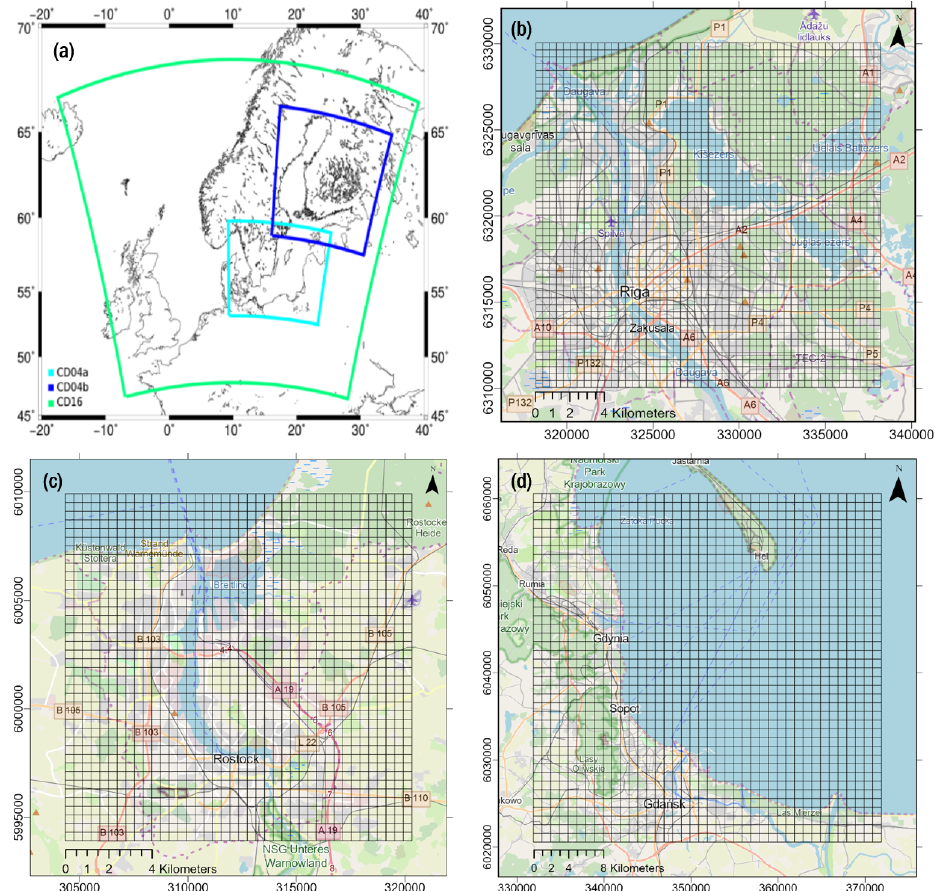
Figure 2. (a) Regional CTM simulation domains, which have been used to drive the local-scale EPISODE-CityChem simulation for the urban domains in (b) Riga and (c) Rostock, with 400m resolution for 20km × 20km and 16km × 16km extent, and (d) Gda´nsk–Gdynia, with 1000m resolution and 40km × 40km extent. Maps are created using © 2018 ESRI Inc. ArcGIS Pro 2.3.2 with a topographic base map by © OpenStreetMap contributors 2019. Distributed under a Creative Commons BY-SA